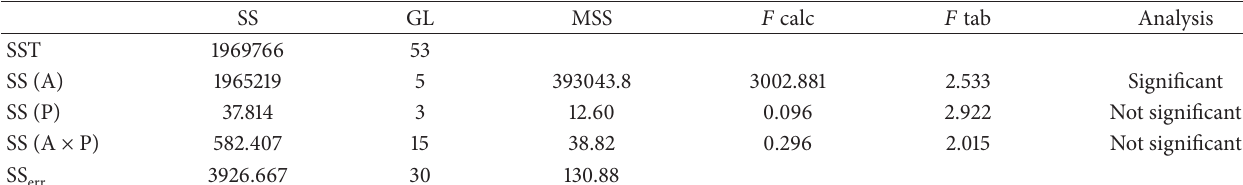
Table 4: Analysis of